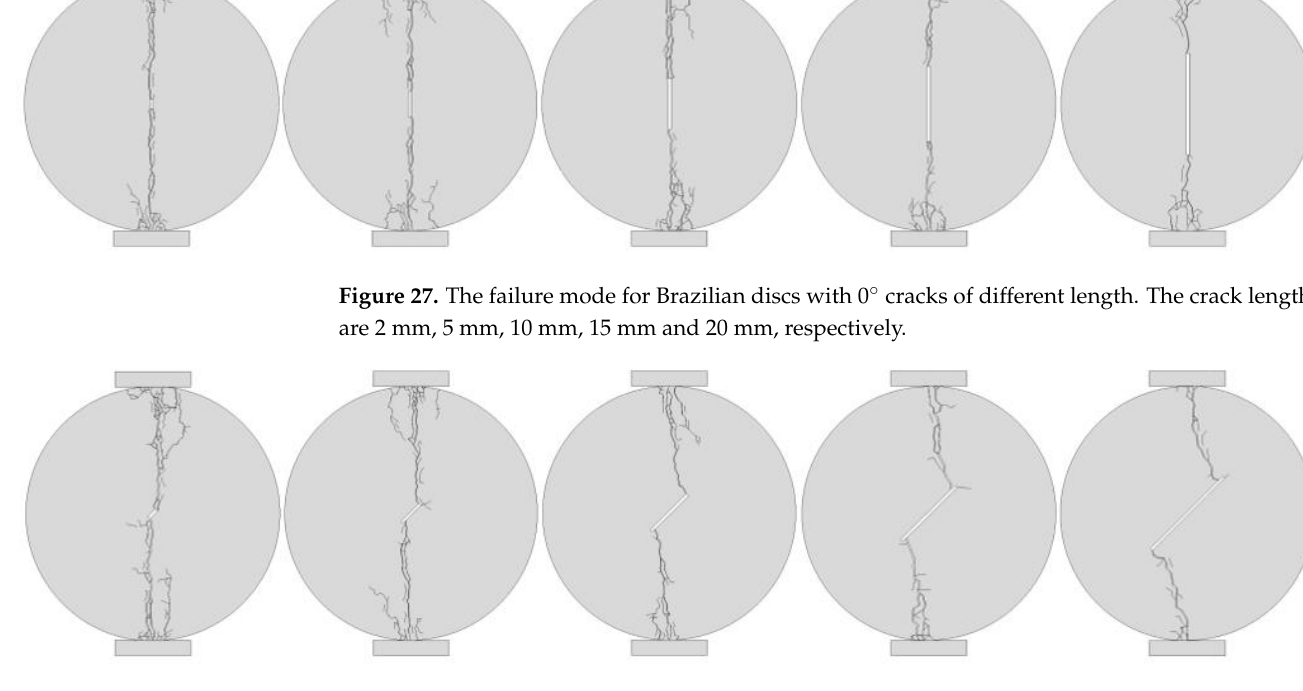
Figure 28. The failure mode for Brazilian discs with 45 ◦ cracks of different length. The crack lengths are 2 mm, 5 mm, 10 mm, 15 mm and 20 mm,